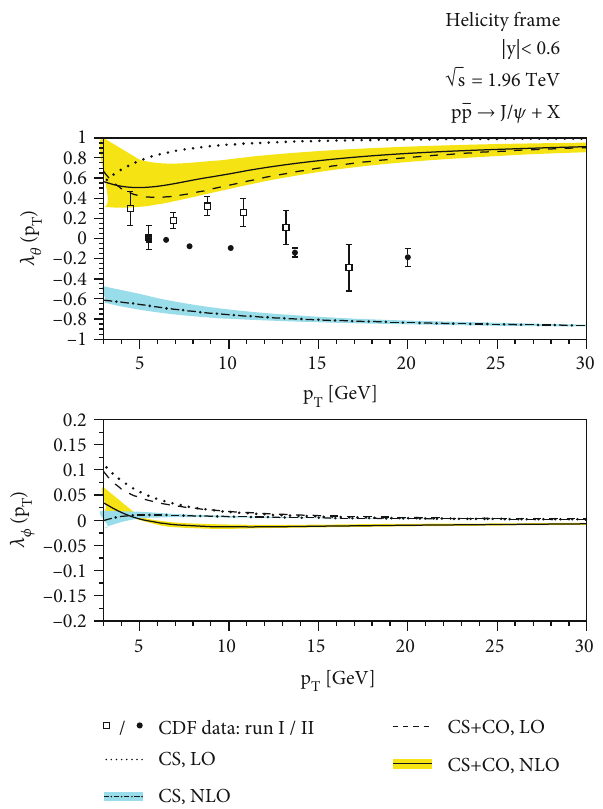
Figure 2: Comparisons of the NLO NRQCD calculations in Ref. [79] for the J / ψ polarization with the Tevatron data. Figure from Ref.